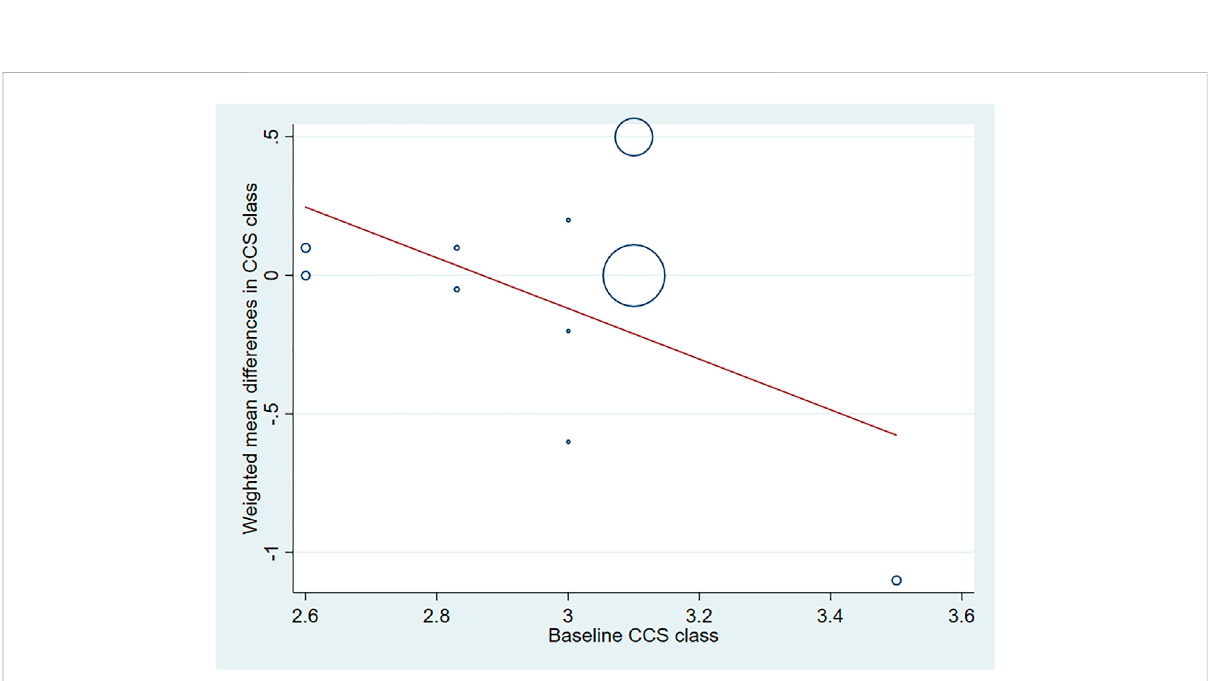
FIGURE 9 Meta-regression plots of the weighted mean difference in CCS angina class according to baseline CCS class ( p = 0.127). CCS, Canadian Cardiovascular Society.